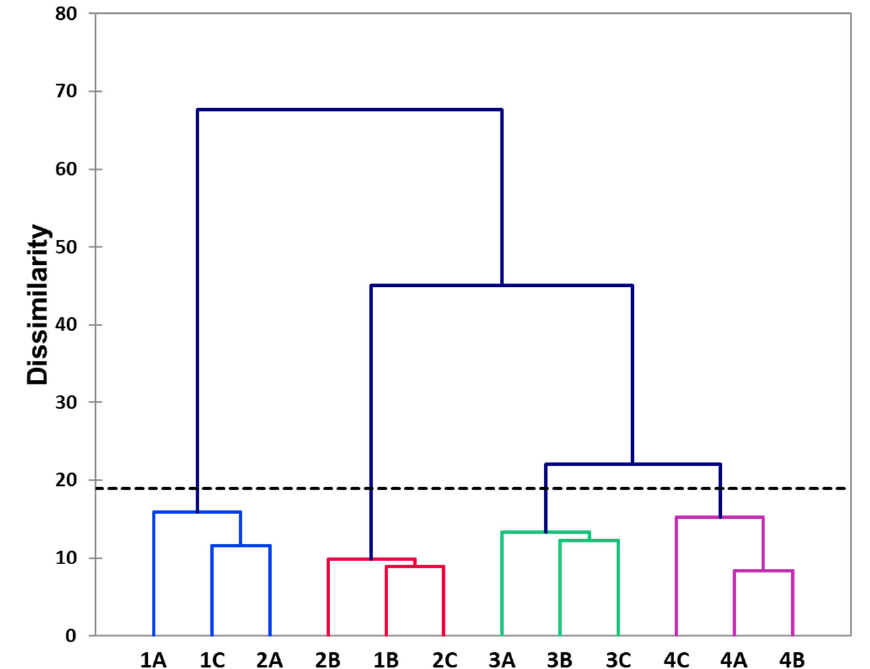
Figure B3 . Hierarchical cluster analysis (HCA) conducted on the samples with the NIF values of the 38 ‘discriminant’ OAs, with discrimination based on both NIF difference threshold and Khi² test (see discussion), displaying four clusters. The data were centered and scaled; dissimilarity Euclidian distances were used with the Ward amalgamation method.